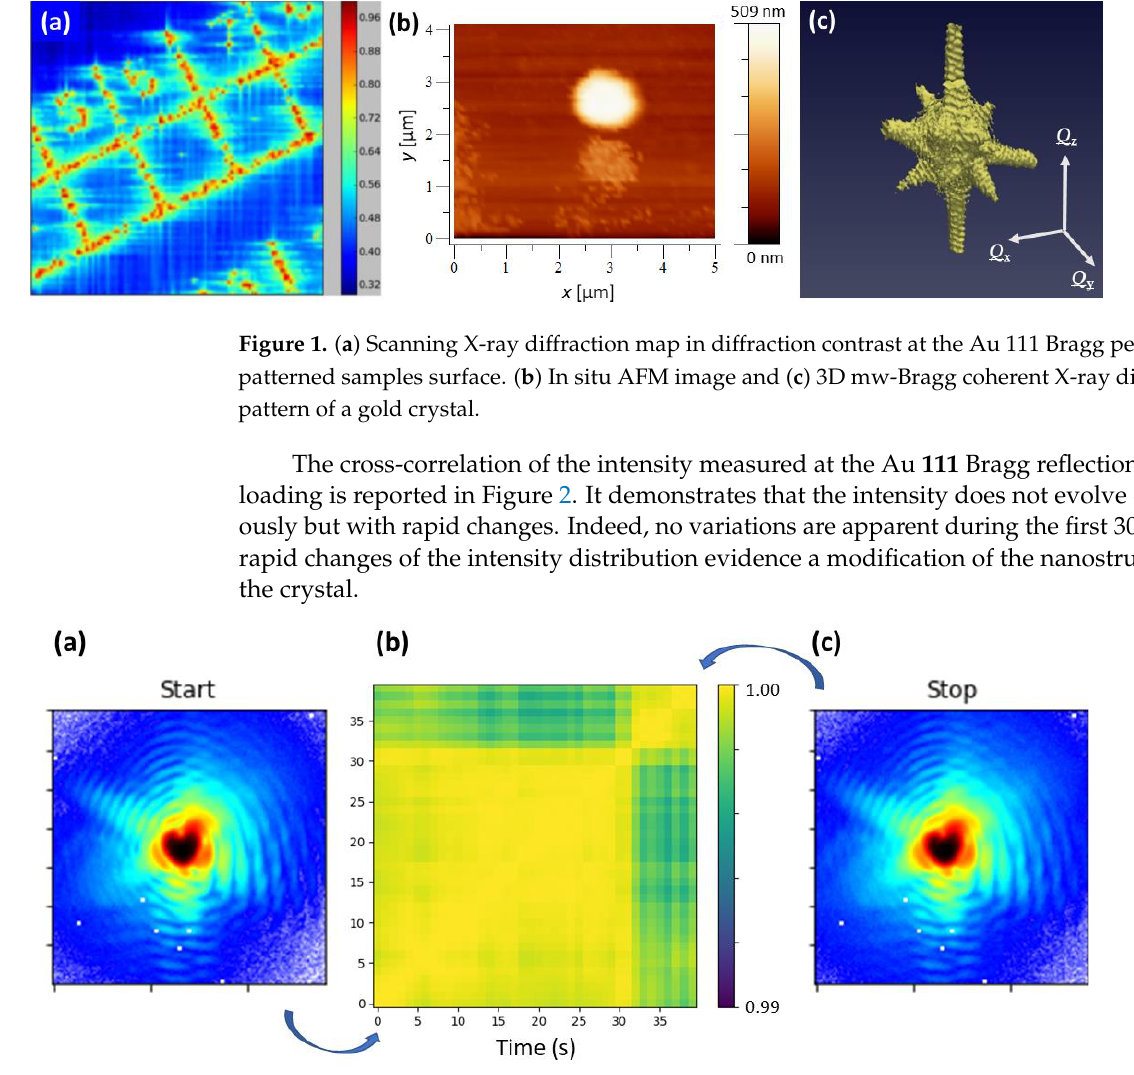
Figure 2. Cross-correlation of the scattered intensity when increasing load from 0.5 µN to 1 µN. ( a ) Slice of the 111 Bragg peak taken at the maximum when starting indentation. ( b ) Cross-correlation of the intensity during loading. ( c ) Slice of the 111 Bragg peak taken at the maximum when stopping indentation. Mw-BCDPs were recorded at 6 different loads up to a maximum force of F = 3.5 µN as well as after complete unloading. Figure 3 shows the intensity in the Q z - Q y plane inte- grated over 40 sections coming from the interpolated 3D diffraction peaks for each force value as well as before contact and after retraction of the SFINX-tip. While the core of the Bragg reflection of the initial crystal is homogeneous in intensity, its intensity gradually decreases, it becomes elongated and finally divides into two parts, creating two distinct peaks. The zoom-in on the core of the Bragg peak displayed in the lower row of Figure 3 clearly shows the evolution of the core of the Bragg reflection which regains its homoge- neity after retraction of the SFINX-tip. It is fully reversible, demonstrating a pseudo-elastic behavior that can only be visualized by in situ experiments while it is invisible for post- mortem studies.